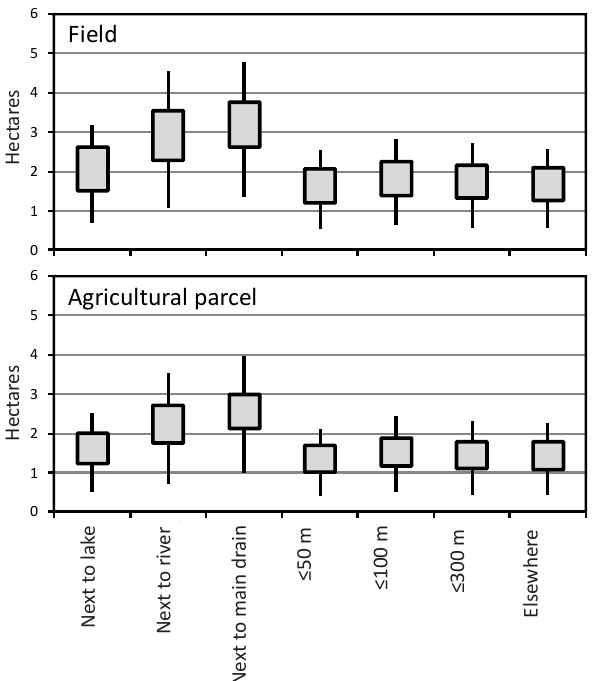
Fig. 3. Field size depending on closeness to waterway compared with fields located at a distance. The upper part of the line indicates upper quartile, the lower part of line lower quartile, the top of the box mean field size (ha) and the bottom of the box median for field size.